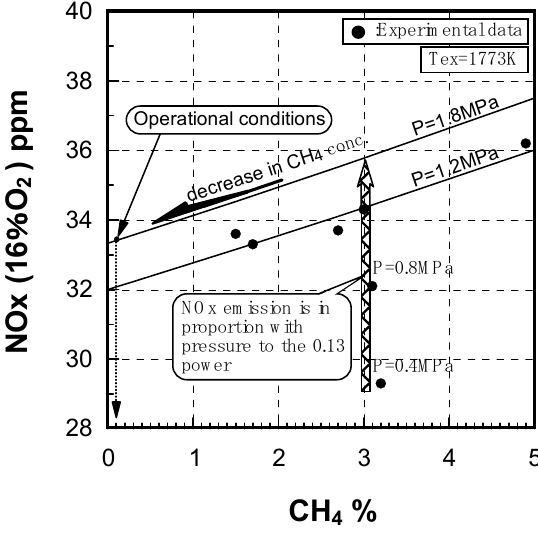
Figure 84. Effects of CH emission